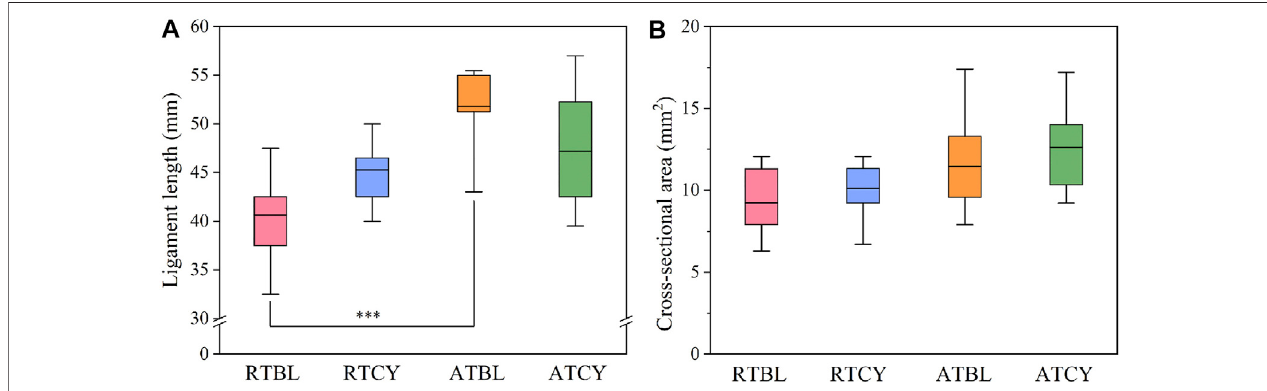
FIGURE 5 | Geometric data of each group: (A) Ligament length; (B) Cross-sectional area. The RTBL and ATBL groups had a signi fi cant difference in ligament length (*** p < 0.001). The box shows the mean ± interquartile range, and the whiskers show the minimum/maximum values.